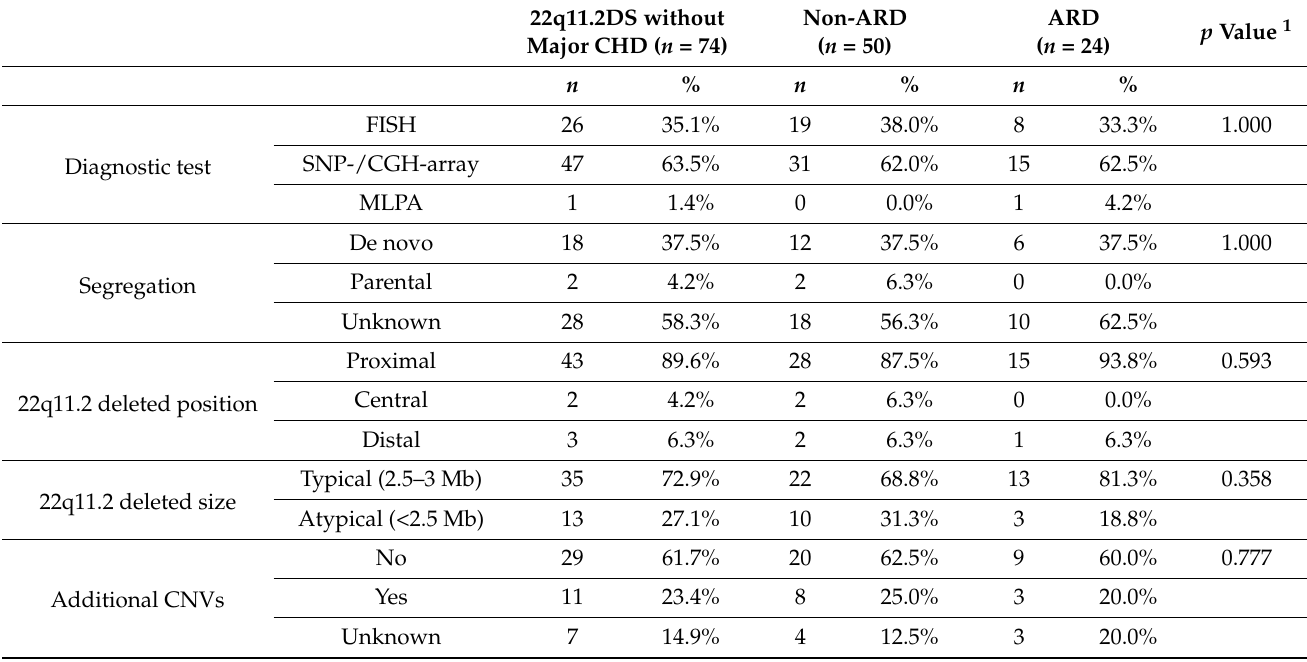
Table 3. Genetic data of the total cohort of 22q11.2DS patients.